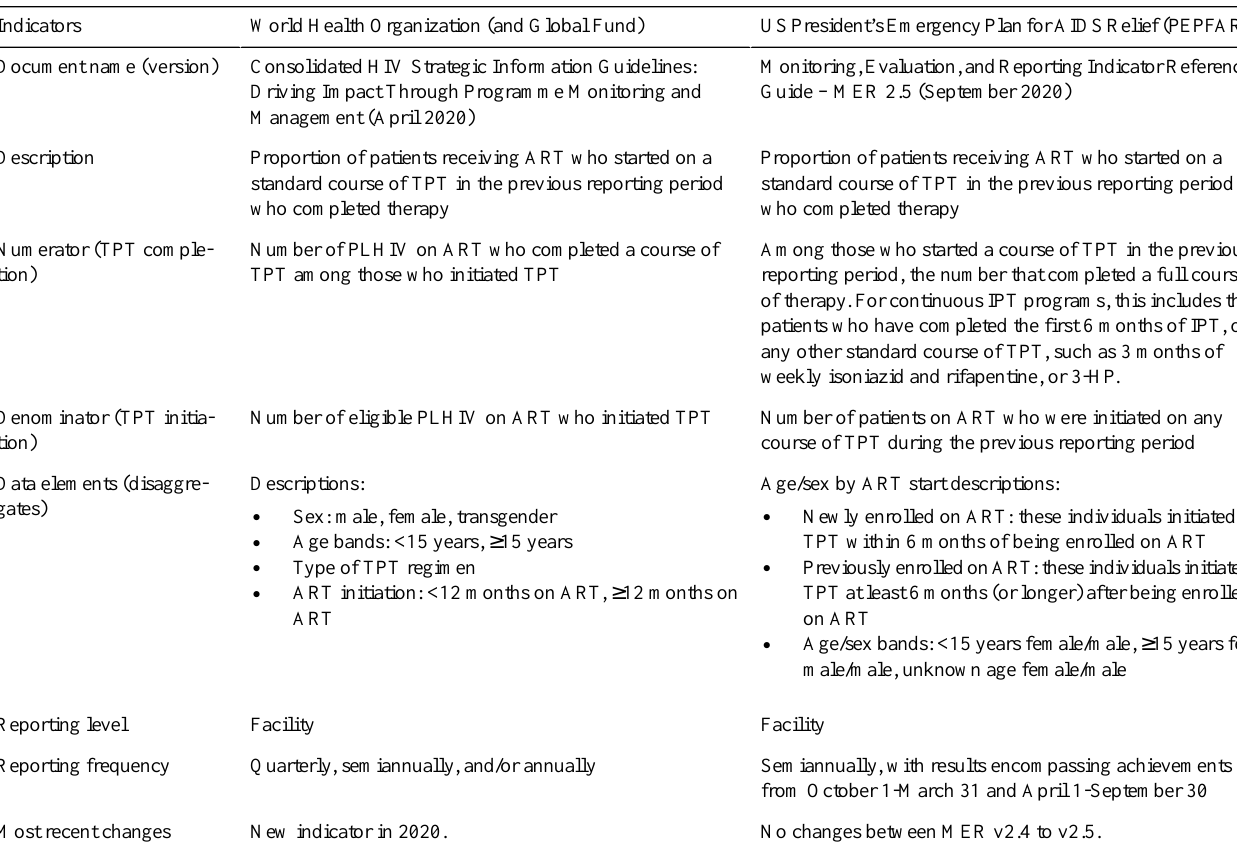
Table 1. A comparison of the World Health Organization and US President’s Emergency Plan for AIDS Relief’s global tuberculosis/HIV indicators a